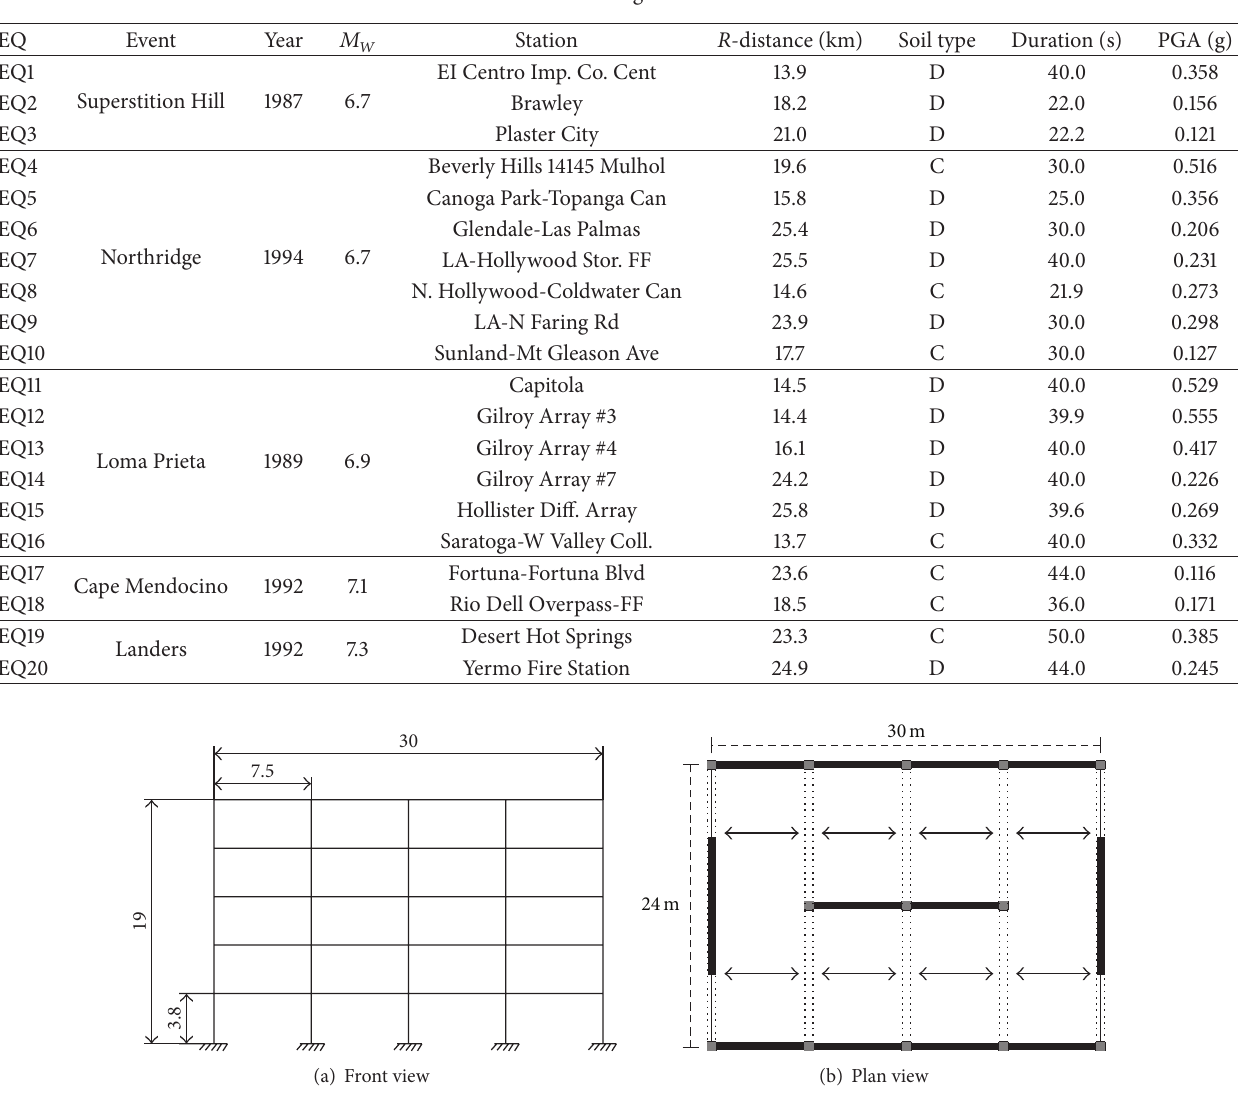
Figure 2: The simulated five-storey shear-type